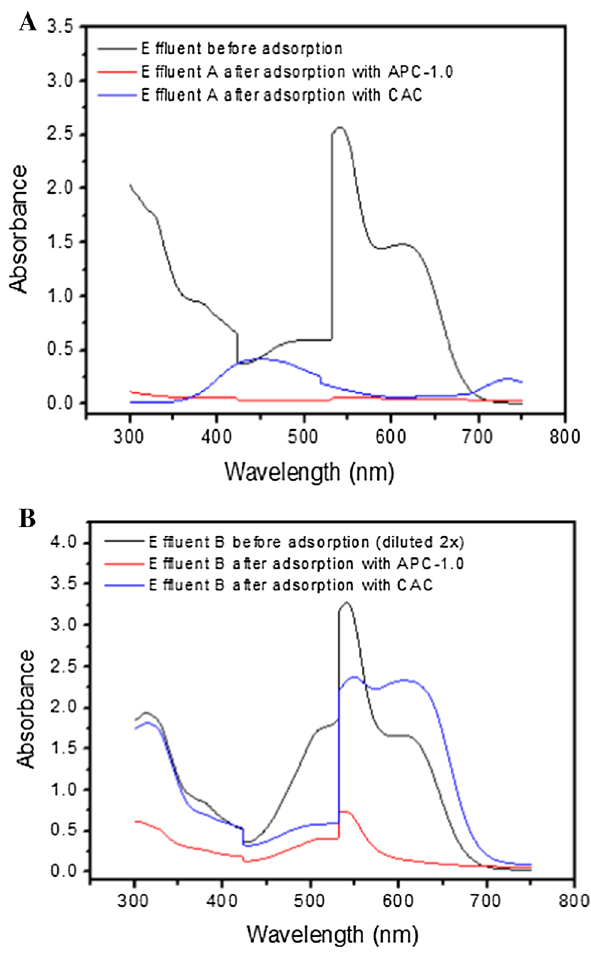
Fig. 7 UV/Visible spectra of simulated dye effluents before and after treatment with APC-1.0 and CAC. a Effluent A; and b effluent B